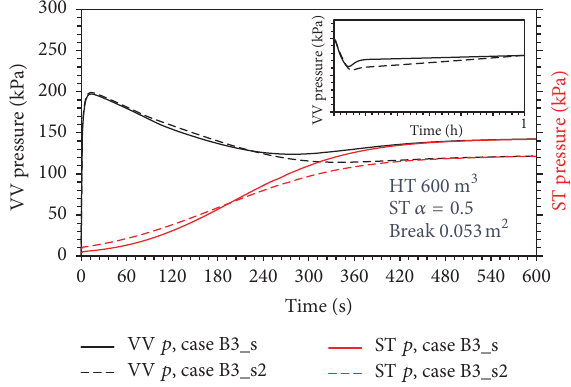
Figure 10: VV and ST pressures (smaller break).